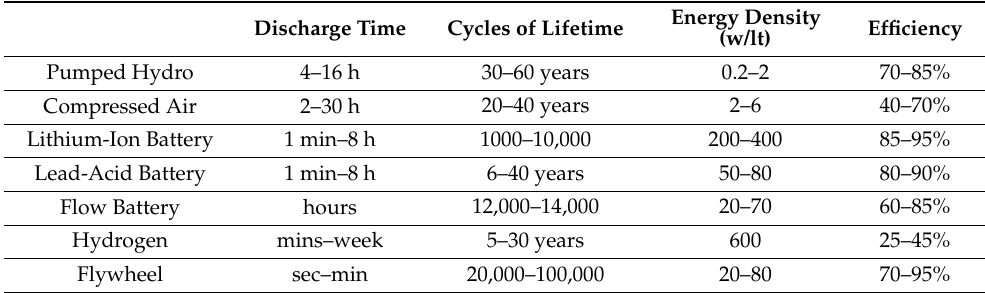
Table 3. Typical features of basic storage methods [47].